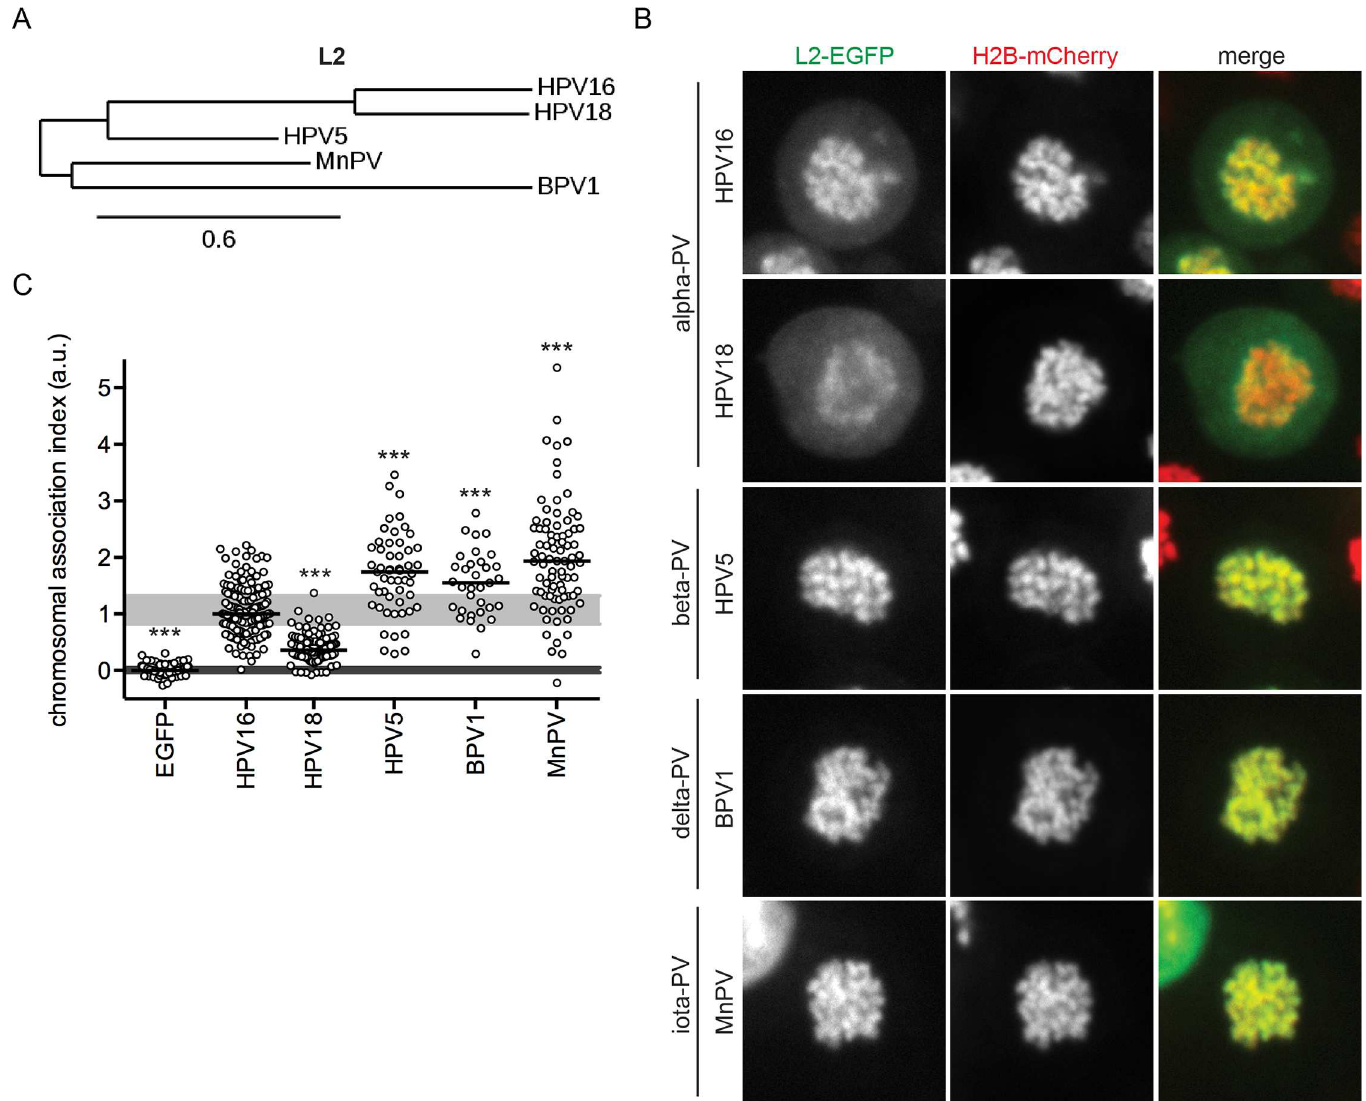
Fig 4. Association of L2 with mitotic chromosomes is conservedamong PVs. (A) The phylogram illustrates the evolutionary relationshipsbetweenthe mucosal high-riskalpha-PVsHPV16 and HPV18, the cutaneous beta-PV HPV5, and the animaldelta- and iota-PV BPV1 and MnPV, respectively,basedon their L2 amino acid sequences.The branch length represents the amount of geneticchanges(scale bar: 0.6 substitutions/site). (B) Images of L2-EGFP (left, green), H2B-mCherry (center, red), and merges (right) are shown for representative cells. (C) The chromosomal associationindicesfor N-terminal deletion mutants are depictedas in Fig 2D. As an exception,only 33 cells were analyzedfor BPV1 L2.